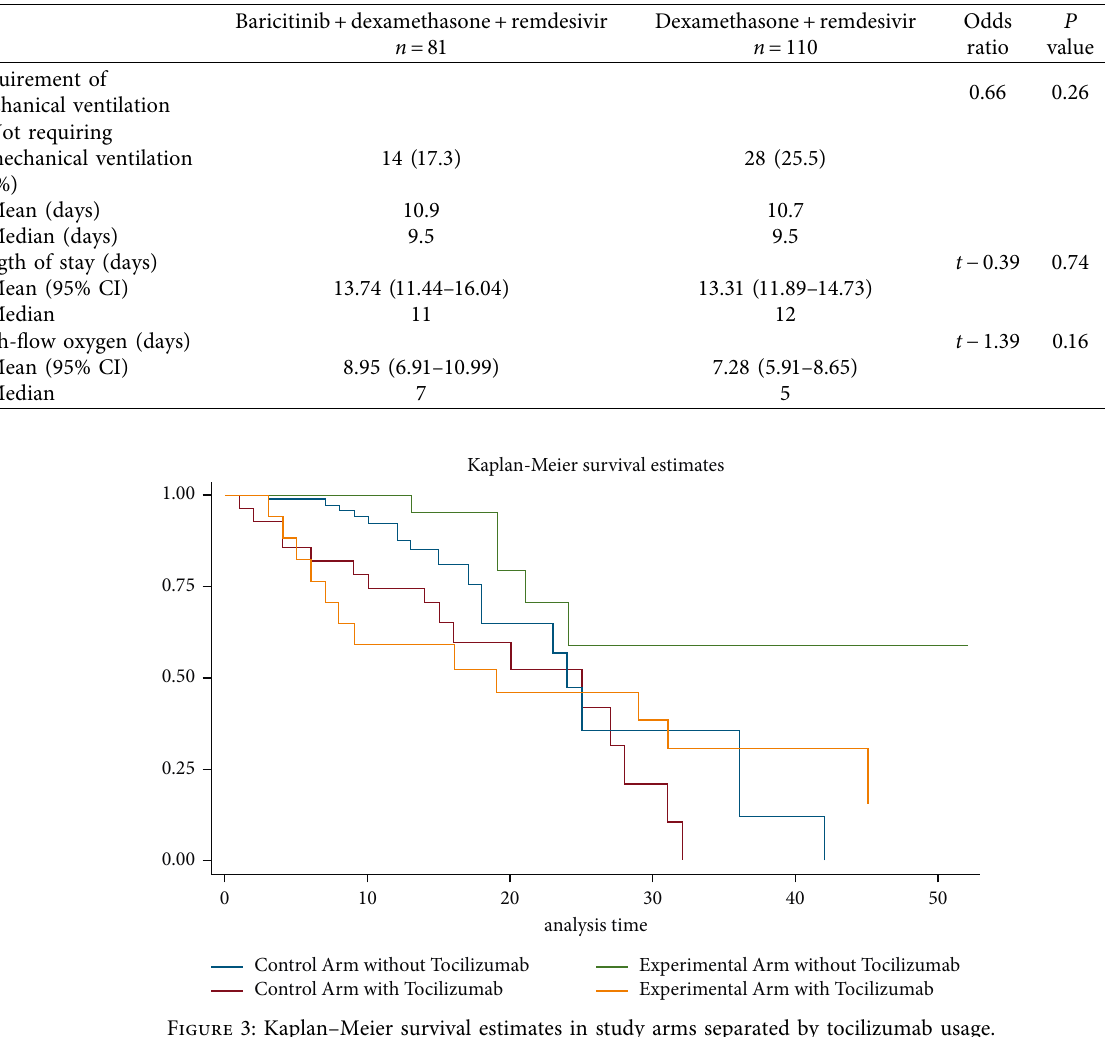
Table 3: Secondary outcomes.